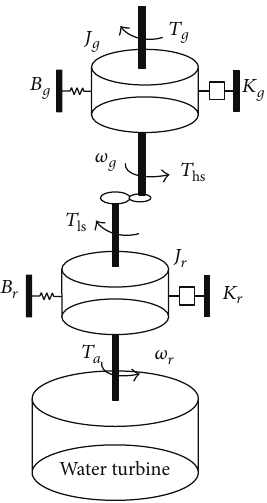
Figure 7: VAT drive train